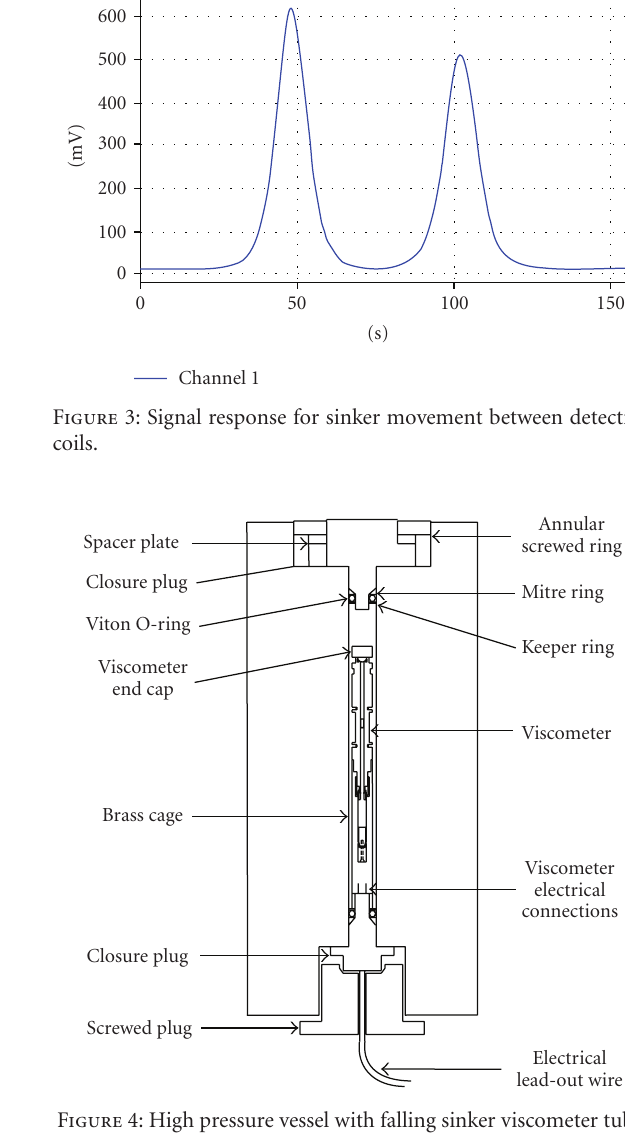
Figure 2: General design of a sinker.